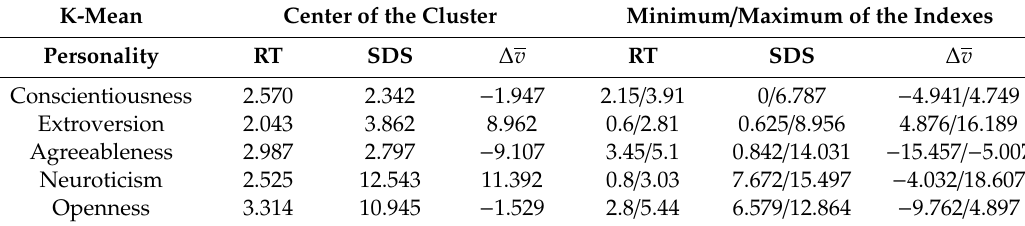
Figure 5. The results of the K-means clustering analysis. Note: RT: response time; SDS: standard deviation of speed; ∆ v : di ff erence of average velocity. Table 3. The basic characteristics of five types of personality states.